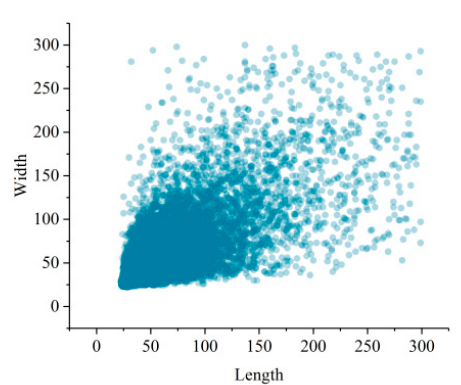
Figure 2. The distribution of the image size of dark patch images.